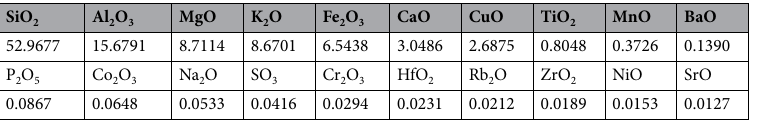
Table 5. XRF results of the copper ores (Wt%).